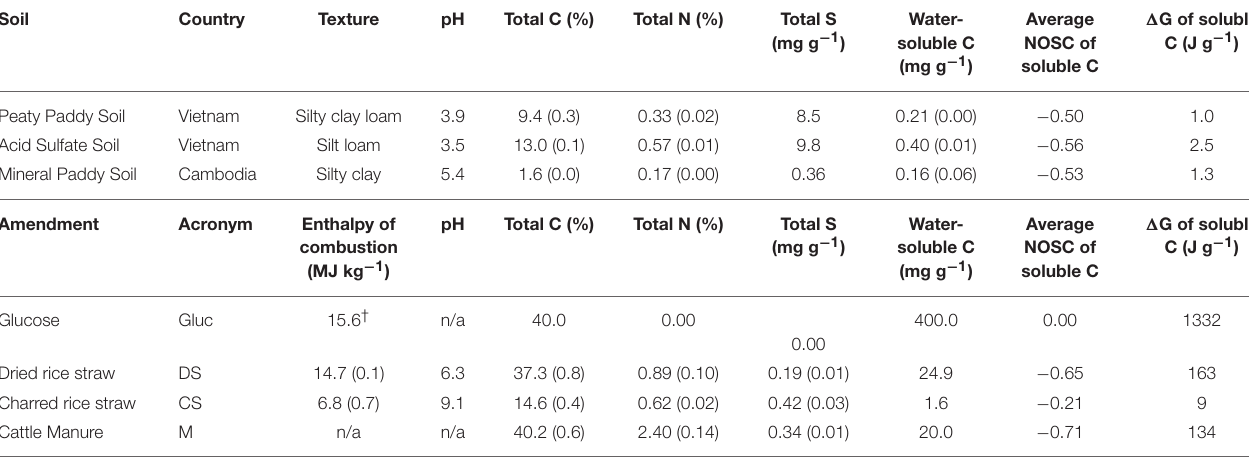
TABLE 1 | Soil and amendment